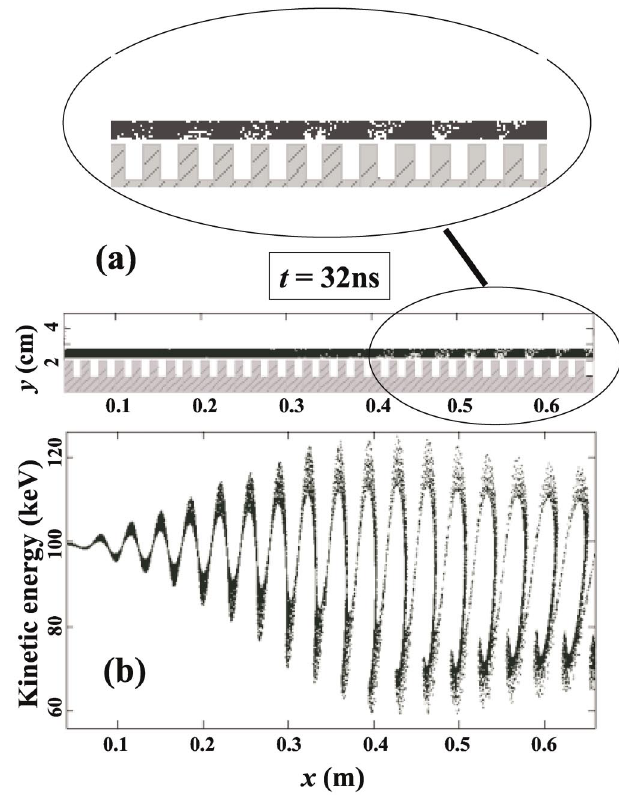
FIG. 6. (a) Current as a function of x at three different times. (b) Current as a function of time at three different locations along the grating.